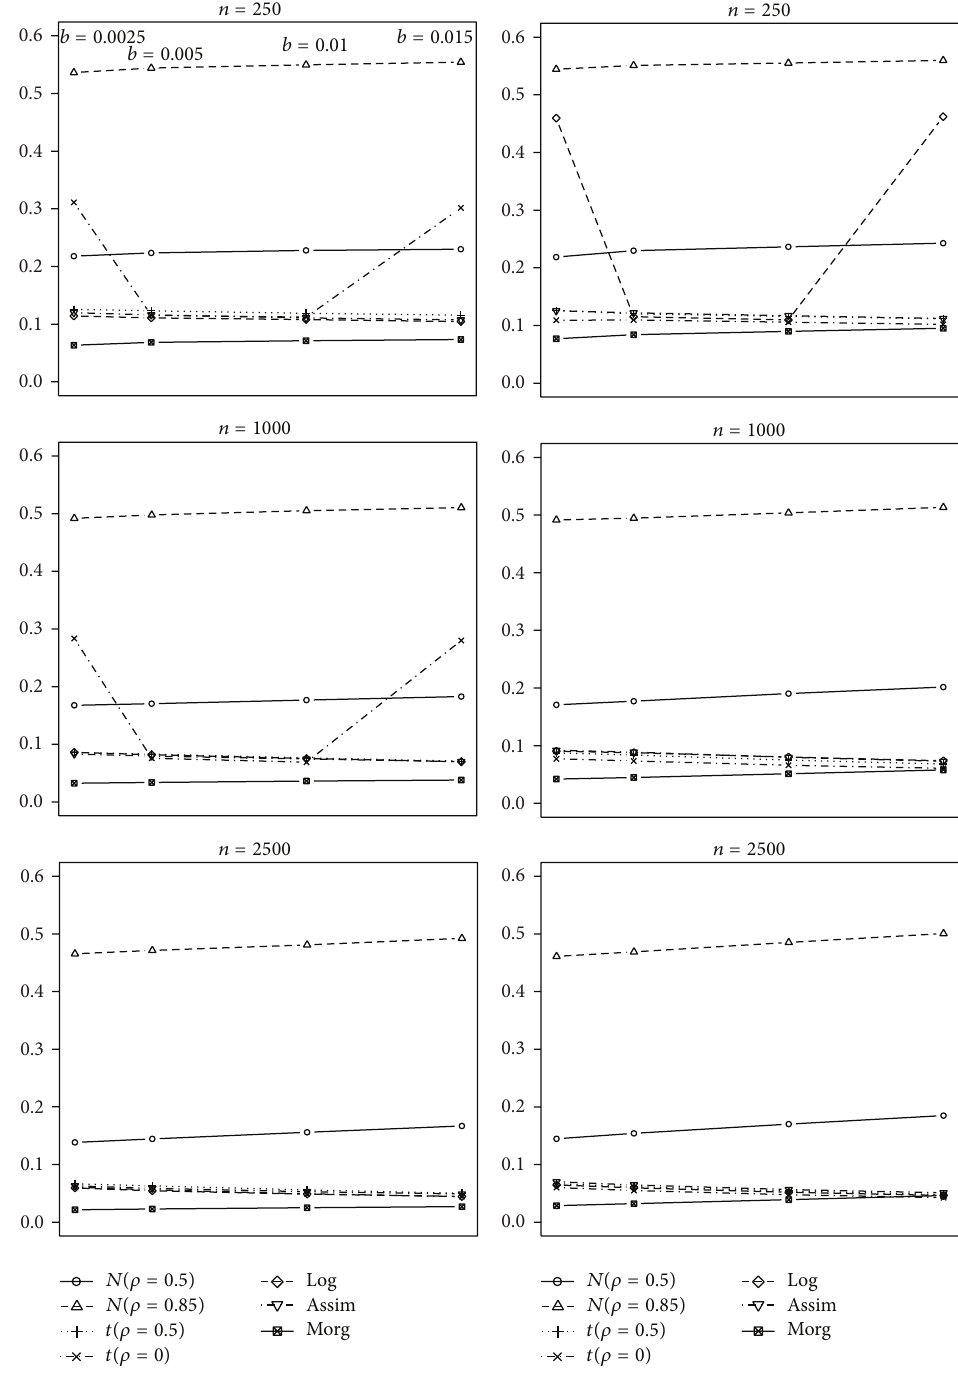
̂ 𝜆 LOG ̂ 𝜆 SEC (a) and estimator (b). The four values plotted in each line correspond to